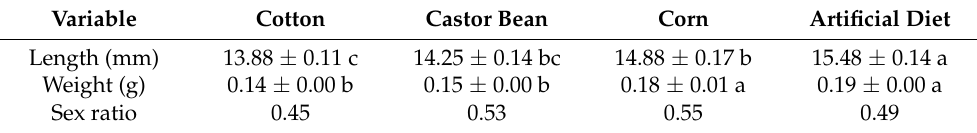
Table 4. Pupae body length and weight and sex ratio (mean ± standard error) of Spodoptera frugiperda (Lepidoptera: Noctuidae) fed on cotton ( Gossypium hirsutum L.), castor bean ( Ricinus communis L.), corn ( Zea mays L.) and an artificial diet at 25 ± 2 ◦ C, relative humidity of 60 ± 10 and photophase of 12 h. Variable Cotton Castor Bean Corn Artificial Diet Length (mm)